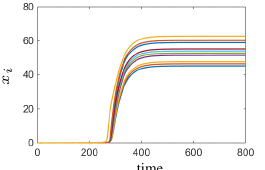
Fig. 7: Time course of the intracellular AHL- concentration of ten cells which all belong to the same colony. The distribution of regulator n l fixed and given by the vector (1 , 2 , 3 , 6 , 7 , 8 , 9 , 12 , 13 , 15)